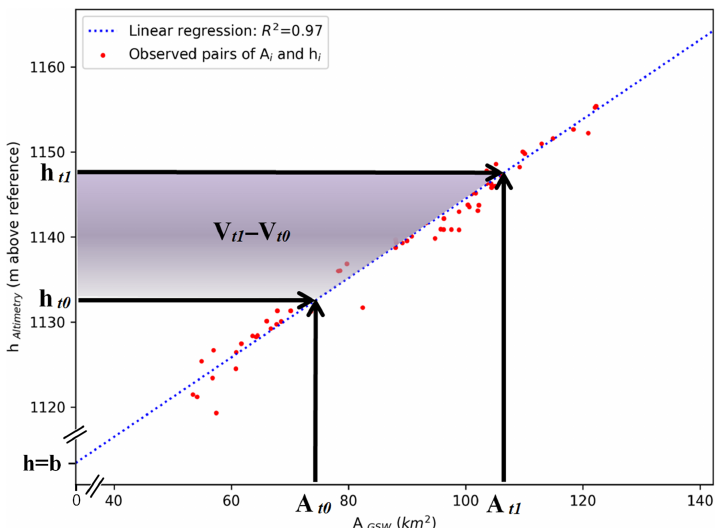
Figure 3. Volume variation calculation for Lake Eucumbene (Australia). The observed monthly pairs of A and h (red dots) are used to estimate a linear regression (blue dashed line) that is used to calculate volumetric changes. The volumetric change from t 0 to t 1 is equal to the purple area and can be visually interpreted as a 2-D lake